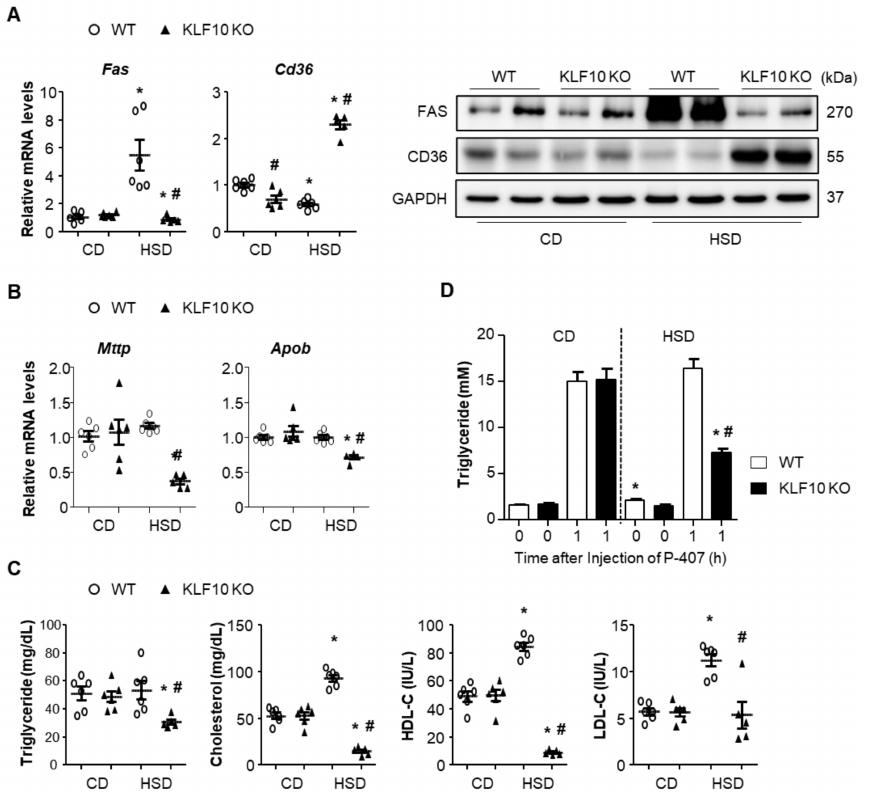
Figure 2. Klf 10 deletion impairs triglyceride package and secretion upon high-sucrose feeding. Eight-week-old WT and Klf 10 KO mice were fed either CD or HSD for eight weeks (n = 5–6 mice/group). Liver genes and proteins involved in ( A ) lipogenesis (fatty acid synthase, FAS), fatty acid uptake (fatty acid translocase, CD36), and ( B ) lipid secretion (microsomal triglyceride transfer protein, MTTP, and Apolipoprotein B, ApoB) were analyzed via qPCR and Western blotting. ( C ) Plasma triglyceride, cholesterol, HDL-cholesterol (HDL-C), and LDL-cholesterol (LDL-C) were measured. ( D ) In vivo VLDL secretion from livers of mice was determined. Eight-week-old WT and Klf 10 KO mice were fed either CD or HSD for one week and then injected with poloxamer 407 (P-407) (n = 6 mice/group). Blood was collected at the indicated time points, and TG was measured. All data are representative of at least three independent experiments and expressed as mean ± SEM. Charts were produced using GraphPad Prism 5.0. Statistical differences were determined by two-way ANOVA with Mann–Whitney U test using SPSS v17.0. * p < 0.05 vs. genotype-matched, CD-fed group and # p < 0.05 vs. diet-matched, genotype control. WT, wild type; KO, knockout; CD, control chow diet; HSD, high-sucrose